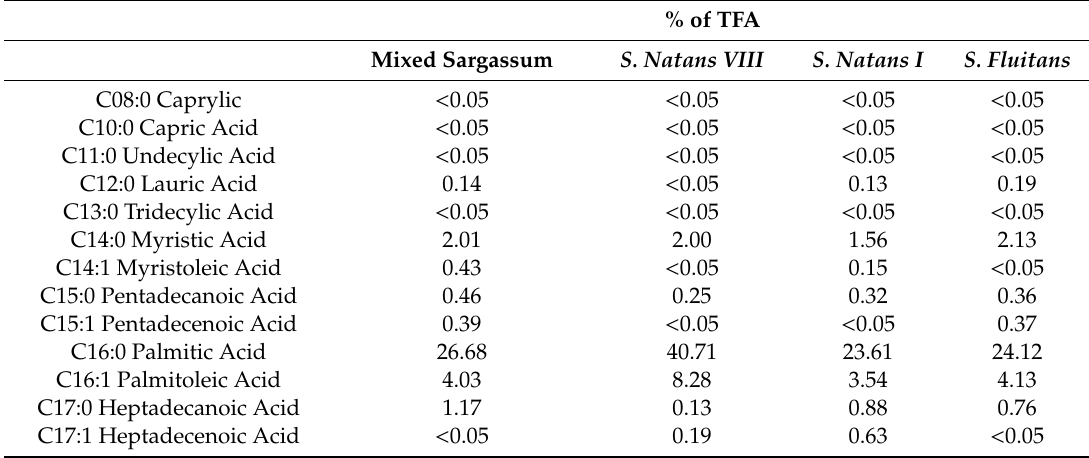
Table 8. The fatty acid profile expressed as the percentage of Total Fatty Acids (TFA) of Sargassum inundation (‘Mixed Sargassum’) and pelagic species of Sargassum from Turks and Caicos ( n =